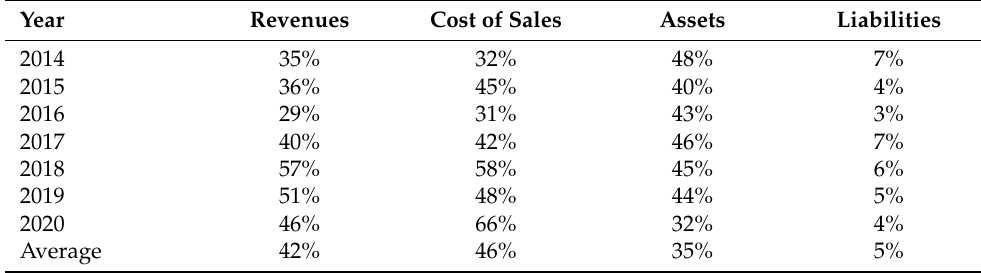
Table 11. Percentage share of the generation segment in particular items of the consolidated